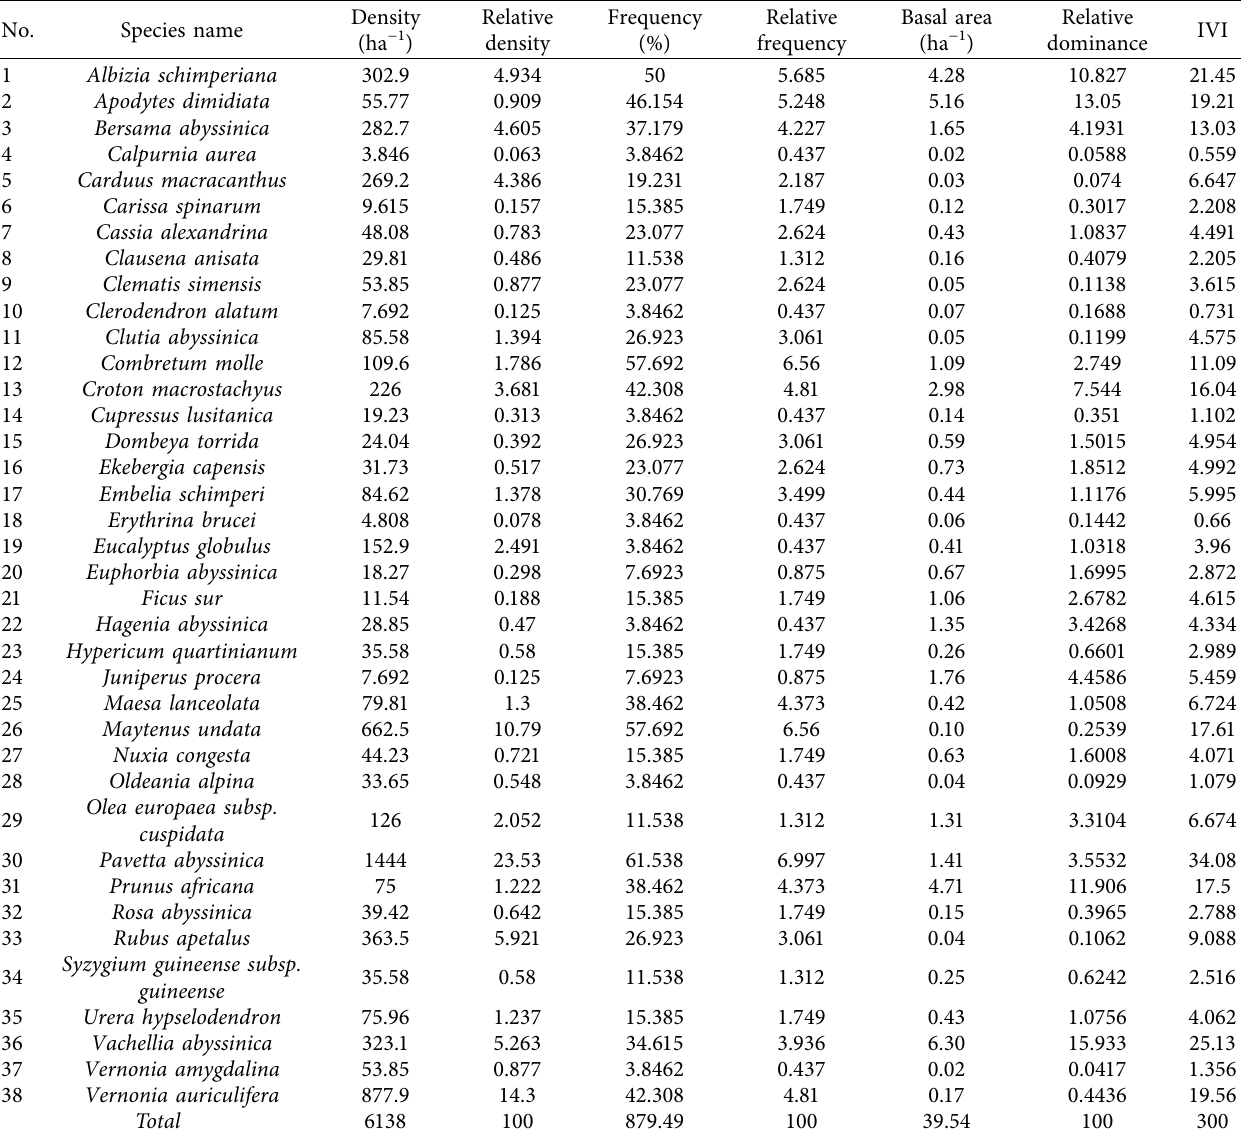
Table 3: Density, relative density, frequency, relative frequency, basal area, relative dominance, and IVI of Kahitassa forest.